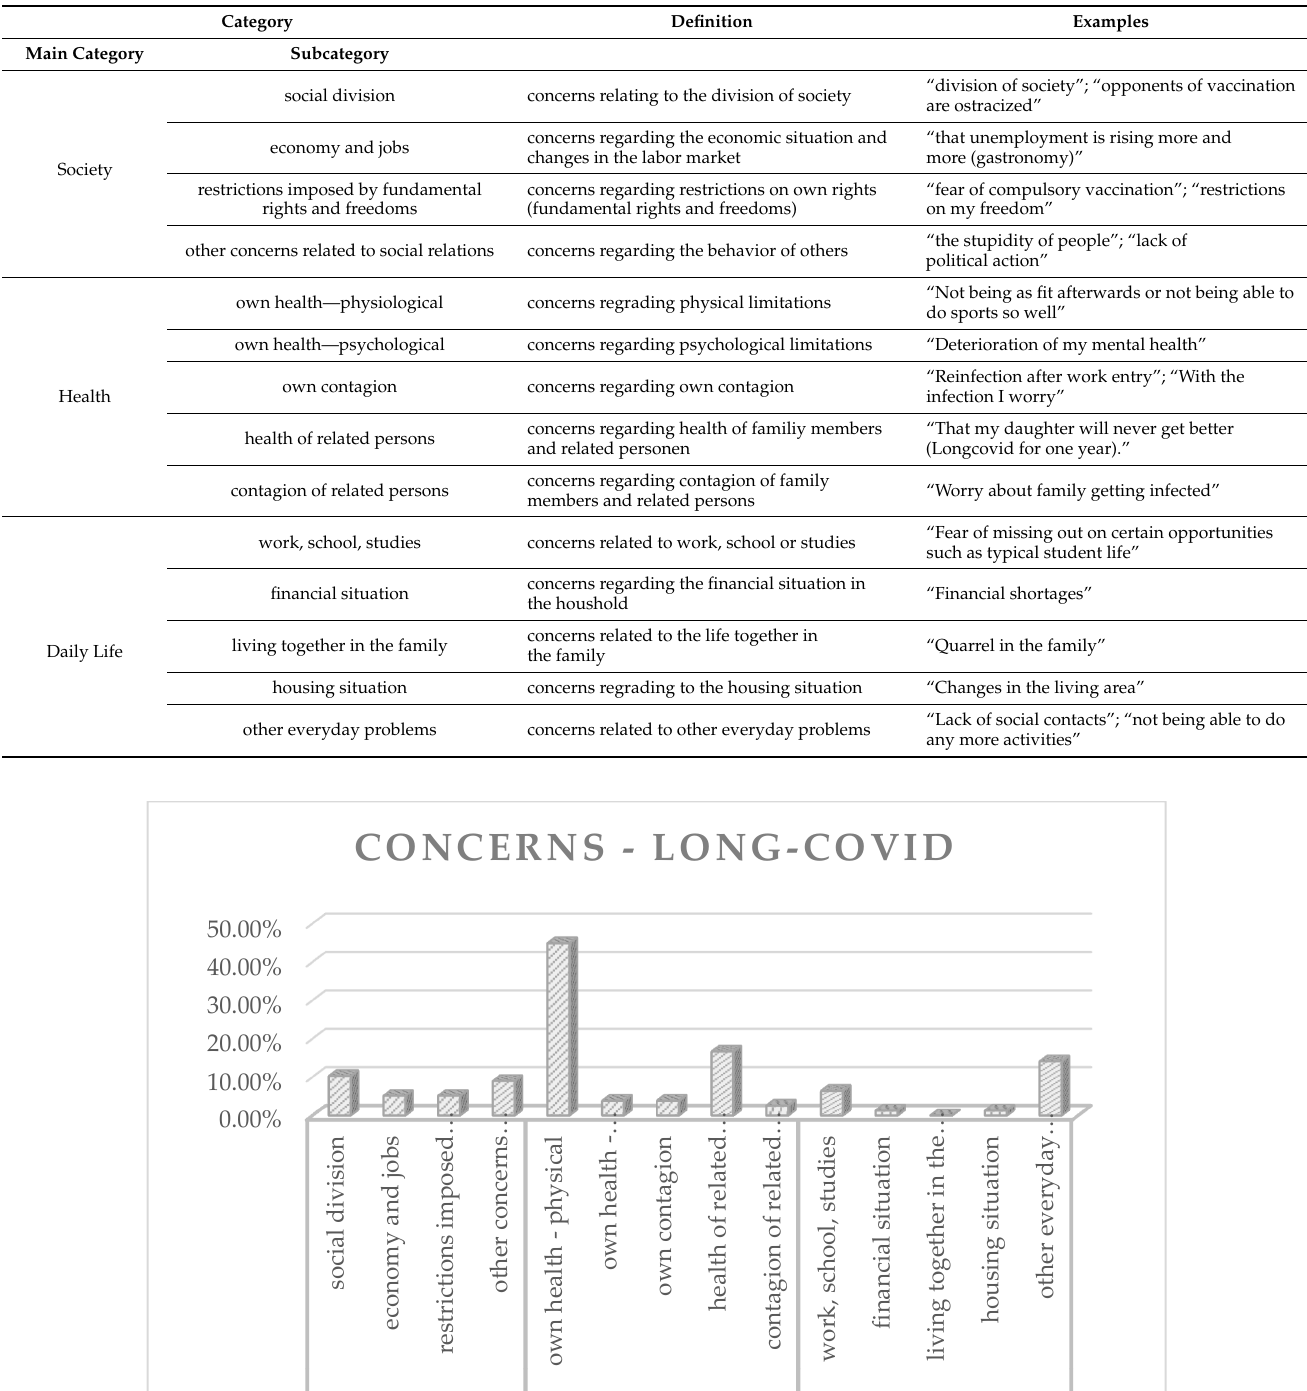
Table 10. Deductive categorization of open question regarding concerns during the COVID-19 pandemic.